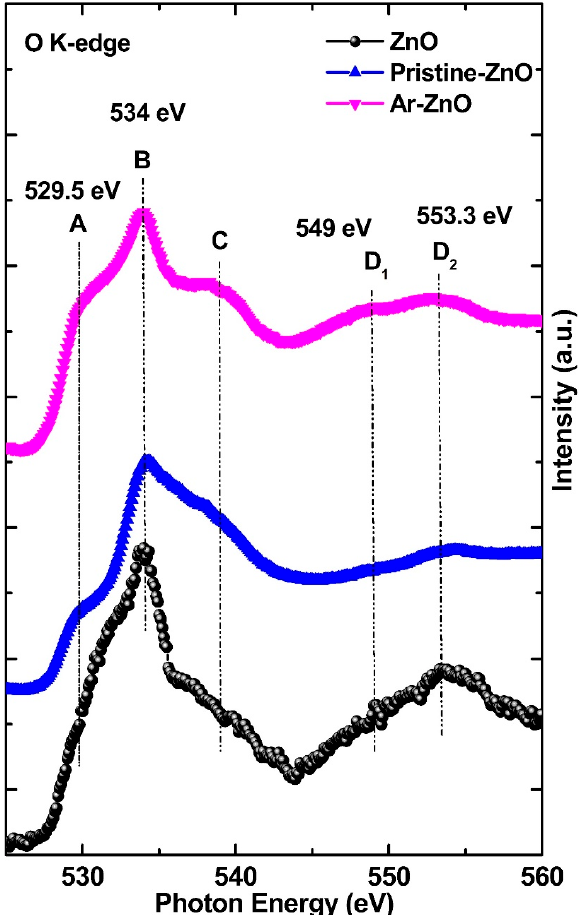
Figure 2. O K-edge spectra in the energy range of 525–560 eV of pristine ZnO and Ar-ZnO, along with standard ZnO.